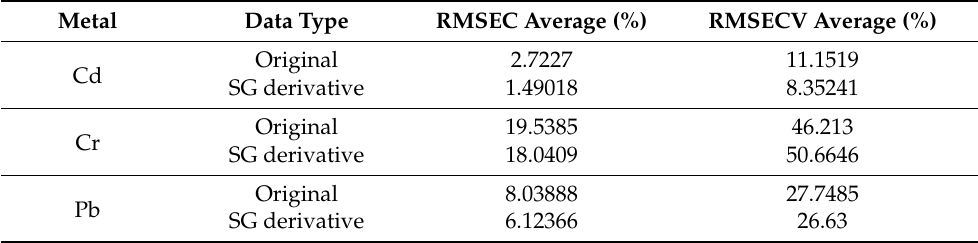
Table 3. The averages (%) in the middle of the values (RMSEC and